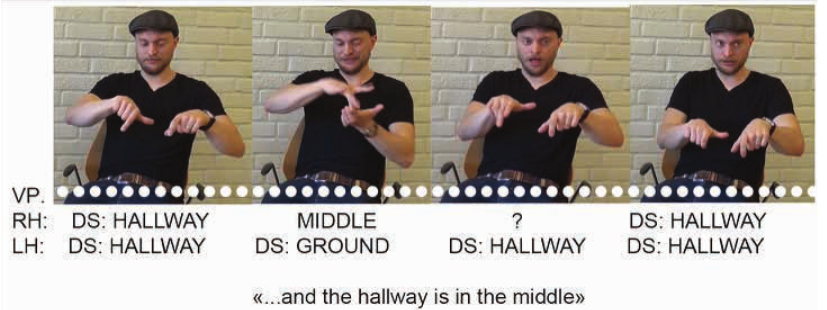
Figure 1: A signer depicts a hallway in a building from a vantage point that is static and external to the conceptualized scene,